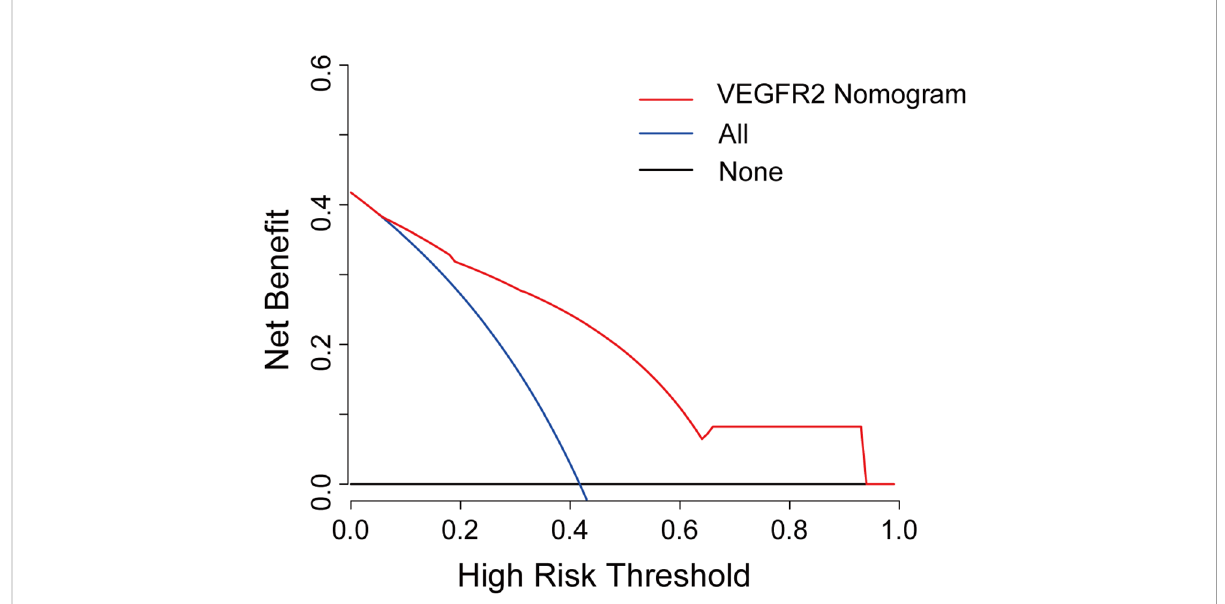
FIGURE 5 Decision curve analysis for the VEGFR2-positive-risk nomogram. The red line represents the nomogram, the blue line represents the condition that all patients are VEGFR2-positive, and the black line represents the condition that no patient harbors detectable VEGFR2 expression. The decision curve reveals that utilizing the VEGFR2-positive-risk model to forecast VEGFR2 expression offers a greater bene fi t than intervening in either all or none of the patients when the threshold probability ranges from 0.07 to